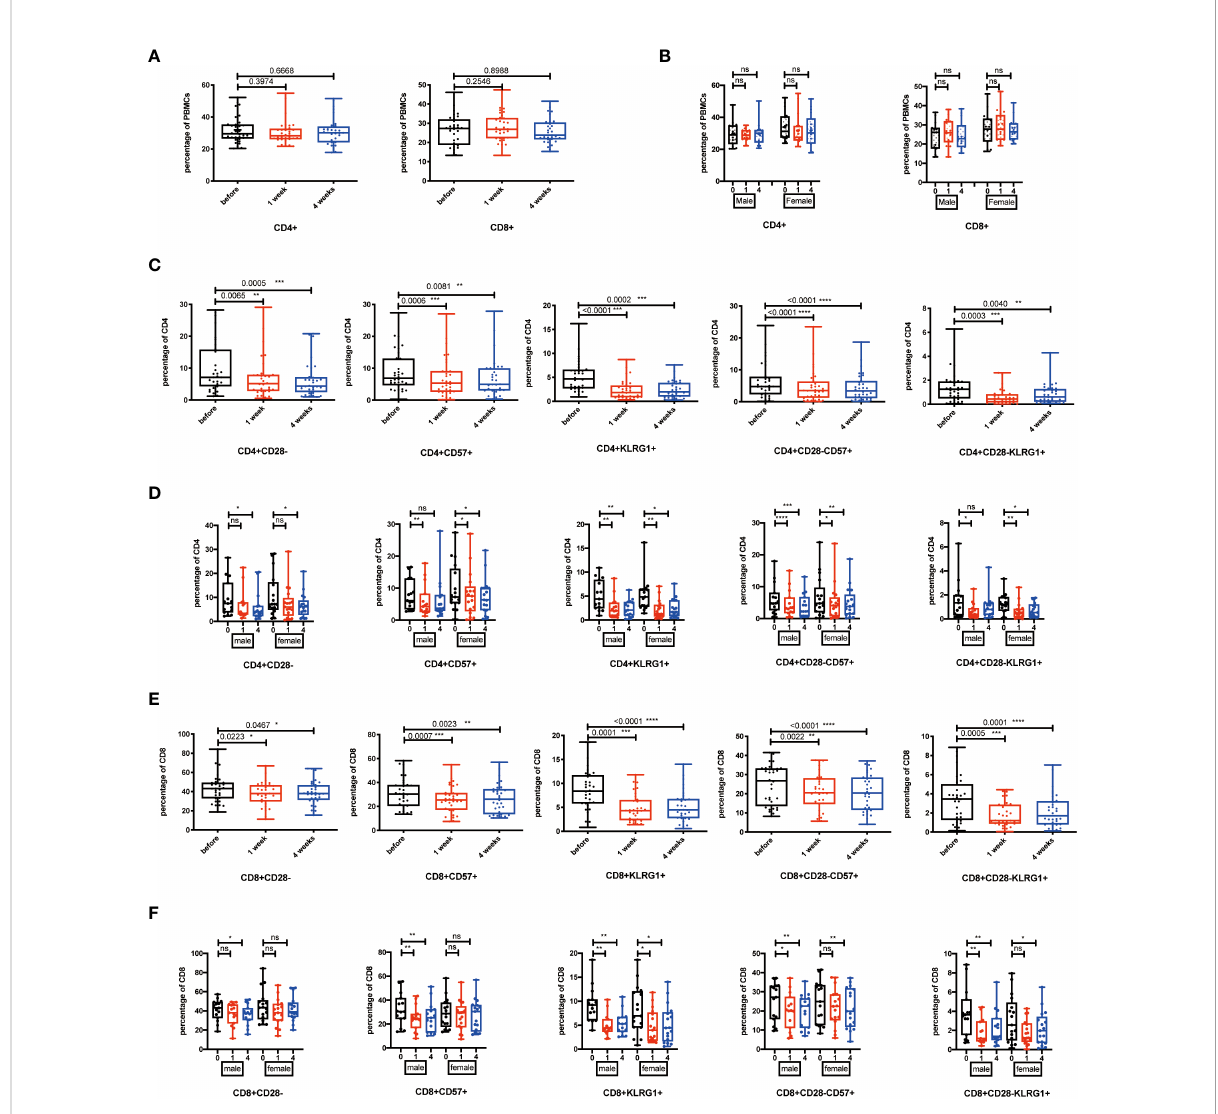
FIGURE 2 Senescent T cells decreased after NK cell infusion. (A) Percentages of CD4 + and CD8 + T cells were analyzed by fl ow cytometry on the 1 week and 4 weeks after NK cell infusion (B) Percentages of CD4 + and CD8 + T cells were analyzed in both sex by fl ow cytometry on the 1 week and 4 weeks after NK cell infusion. (C) Percentages of CD28 - , CD57 + , KLRG1+, CD28 - CD57 + , and CD28 - KLRG1 + CD4 + T cells were analyzed by fl ow cytometry on the 1 week and 4 weeks after NK cell infusion. (D) Percentages of CD28 - , CD57 + , KLRG1+, CD28 - CD57 + , and CD28 - KLRG1 + CD4 + T cells were analyzed in both sex by fl ow cytometry on the 1 week and 4 weeks after NK cell infusion. (E) Percentages of CD28 - , CD57 + , KLRG1 + , CD28 - CD57 + , and CD28 - KLRG1 + CD8 + T cells were analyzed by fl ow cytometry on the 1 week and 4 weeks after NK cells infusion. (F) Percentages of CD28 - , CD57 + , KLRG1+, CD28 - CD57 + , and CD28 - KLRG1 + CD8 + T cells were analyzed in both sex by fl ow cytometry on the 1 week and 4 weeks after NK cell infusion. Each marker has detected 32 volunteers; 15 volunteers are involved in the male group, and 17 volunteers are involved in the female group. * p < 0.05; ** p < 0.01; *** p < 0.001; **** p < 0.0001. ns, no